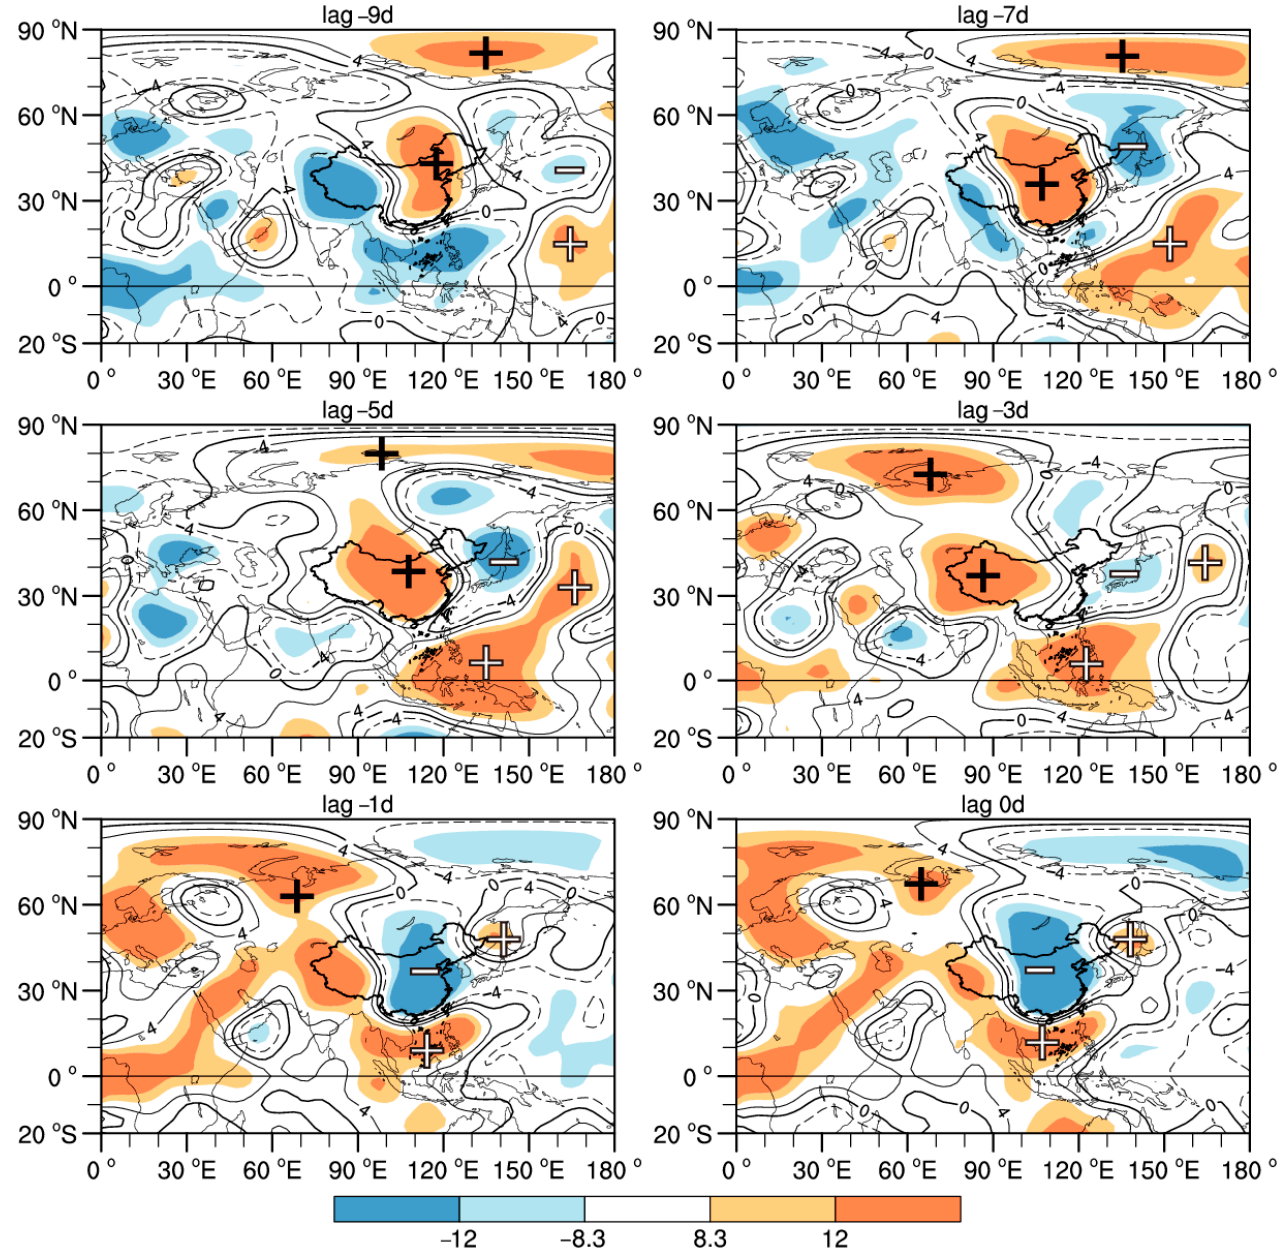
Figure 11. Same as Figure 10, but in drought